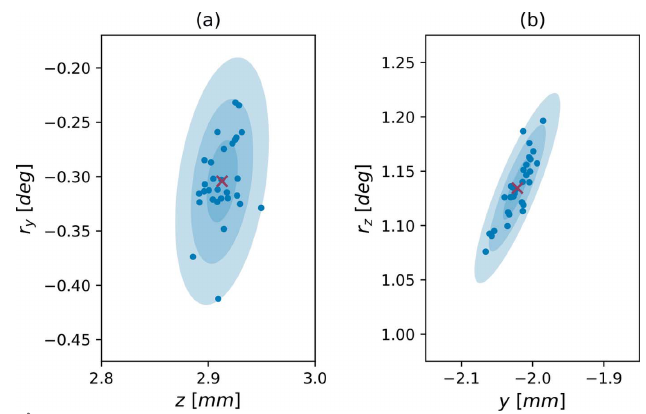
Figure 6 Together, these scatter plots depict the best motor position recorded prior to manual termination of 30 executions of Algorithm A.1 (blue dots). The cross (red) represents the average of these recorded positions. We further illustrate the 68, 95, and 99.7% uncertainty regions as concentric ellipses centered at the mean. Panel ( a ) presents the z and r y axes, while the y and r z axes are in given in panel ( b ). Each execution was initialized from the same region in (cid:3) , but the initial simplex was selected randomly (distributed uniformly) about p 0